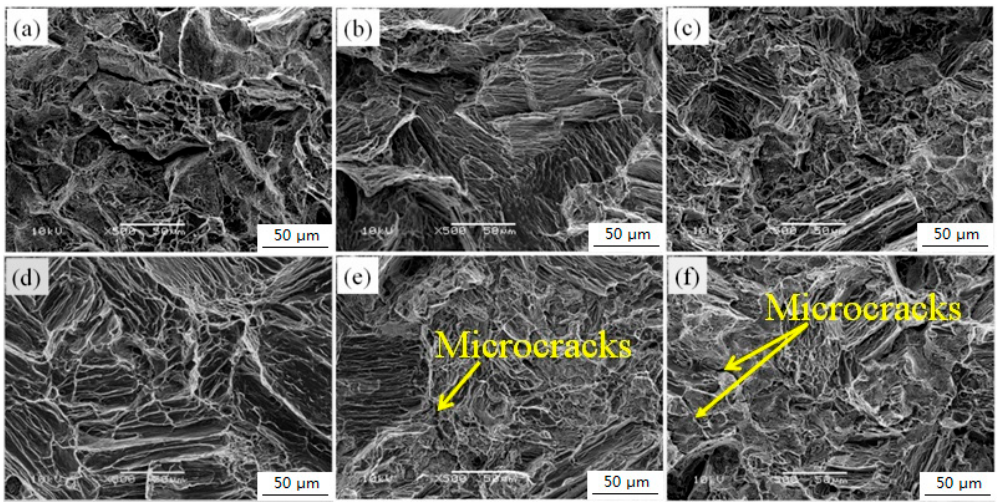
Figure 8. SEM images of fracture surfaces of Mg–2.0Zn–0.5Zr–xGd alloys: ( a ) x = 0; ( b ) x = 1; ( c ) x = 2; ( d ) x = 3; ( e ) x = 4; ( f ) x = 5.